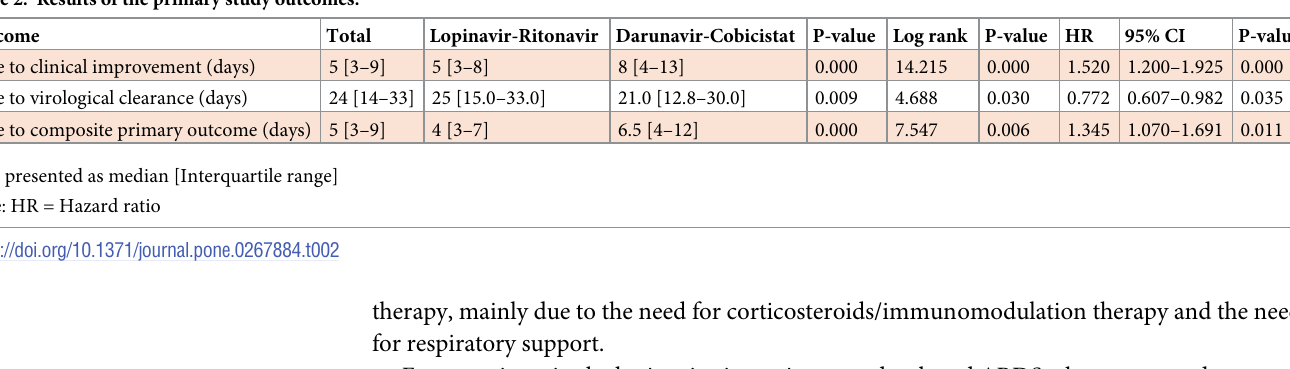
for respiratory support. Fewer patients in the lopinavir-ritonavir group developed ARDS when compared to patients who received darunavir-cobicistat (p = 0.001). Furthermore, the length of hospital cause mortality at day 30 was significantly lower in the lopinavir-ritonavir group when com- pared to the darunavir-cobicistat group (p = 0.001).